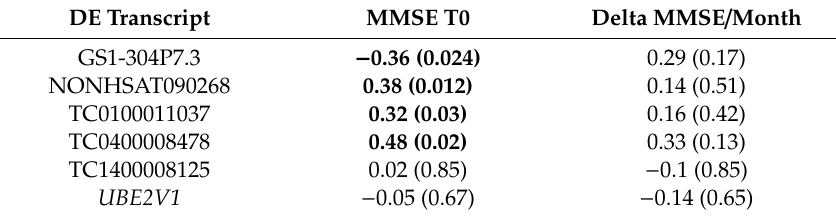
Table5. CorrelationanalysisbetweenplasmalevelsofDEtranscriptsandclinicopathologicalparameters. For each transcript / parameter pair, the r -value (Pearson or Spearman correlation coe ffi cient, according to normality of distributions) and the p -value corrected for multiple comparison (between brackets) are shown. Significant values are highlighted in bold. MMSE: Mini Mental State